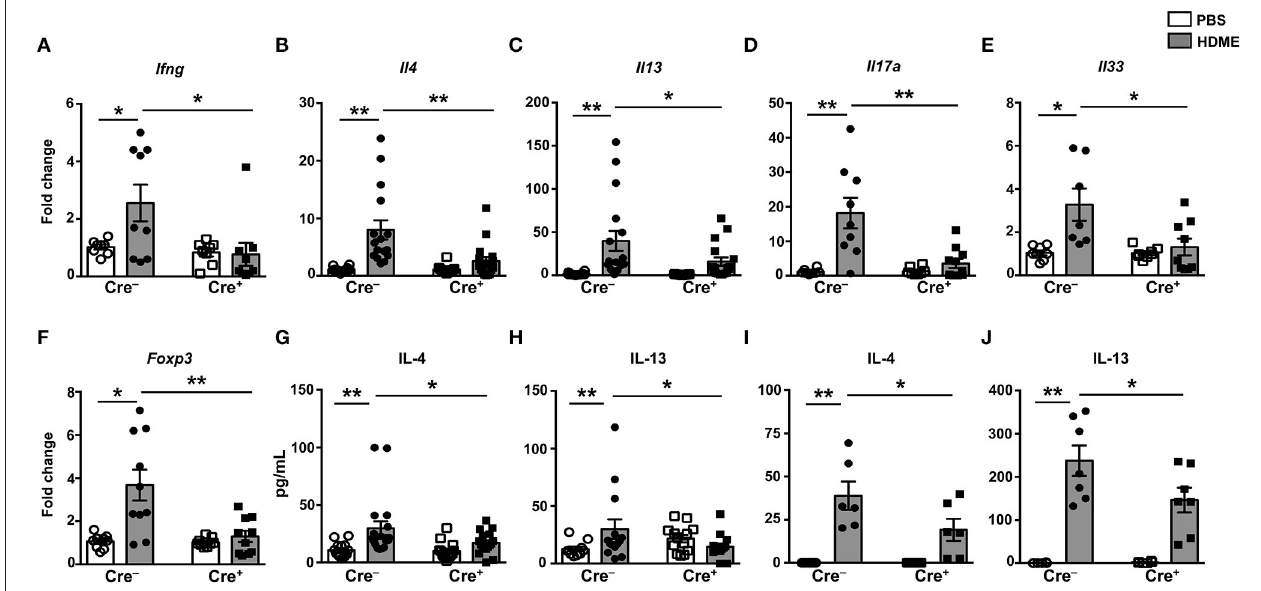
FIGURE 6 | Mice with GRK2-deficient T cells have reduced inflammatory cytokines in lungs following exposure to HDME. (A–F) Lungs from Cre − and Cre + mice injected with PBS or HDME were analyzed for gene expression of (A) the Th1 cytokine ( Ifng ), (B,C) Th2 cytokines ( Il4 and Il13 ), (D) Th17 cytokine ( Il17a ), (E) alarmin ( Il33 ), and (F) Foxp3 ( Foxp3 ). (G) IL-4 and (H) IL-13 cytokine levels in the BALF supernatant of Cre − and Cre + mice challenged or not with HMDE are shown. (I,J) Lung mononuclear cells were harvested from Cre − and Cre + mice injected with PBS or HDME. The cells were re-exposed to HDME and (I) IL-4 and (J) IL-13 cytokine levels in the supernatant were estimated. Data is shown as mean ± SEM and pooled from 2 to 3 independent experiments with a total of 6–17 male and female mice per cohort Statistical significance was determined by Student’s unpaired t -test. * p ≤ 0.05, ** p ≤ 0.01.